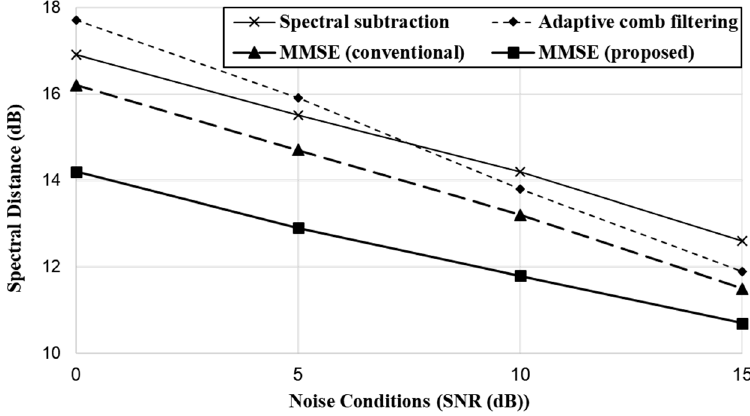
Figure 10. Comparison of noise reduction performance based on SD.